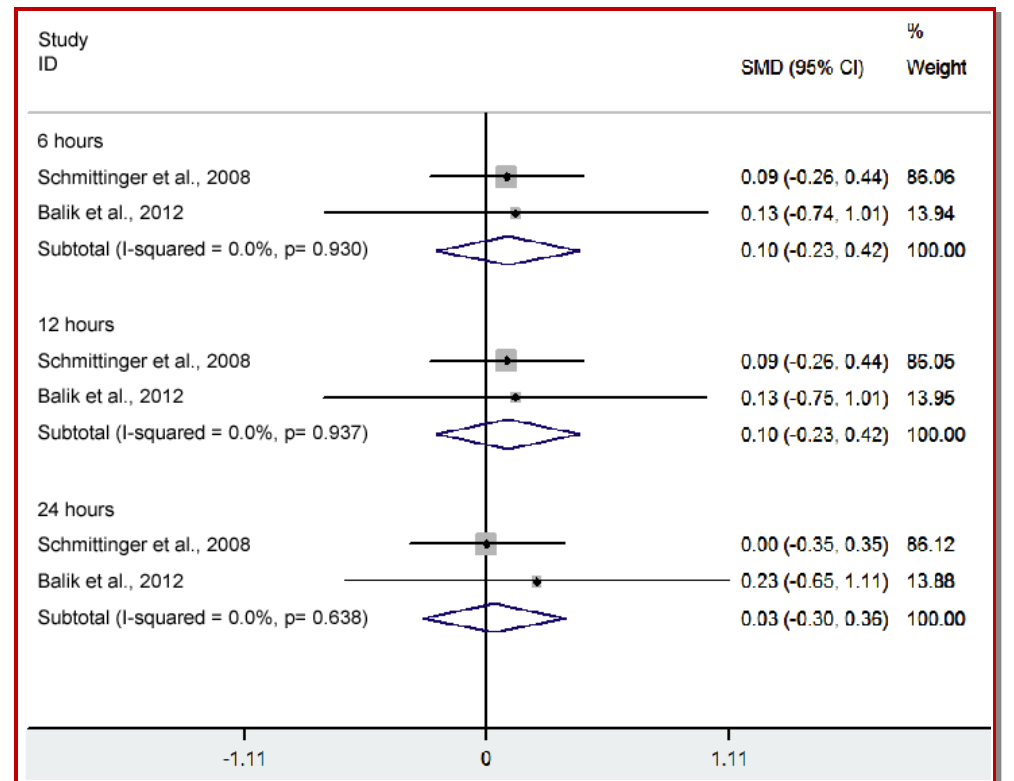
Figure 9: Meta-analysis of beta-blocker on the noradrenaline dosage (digit within the parenthesis means the number of studies for